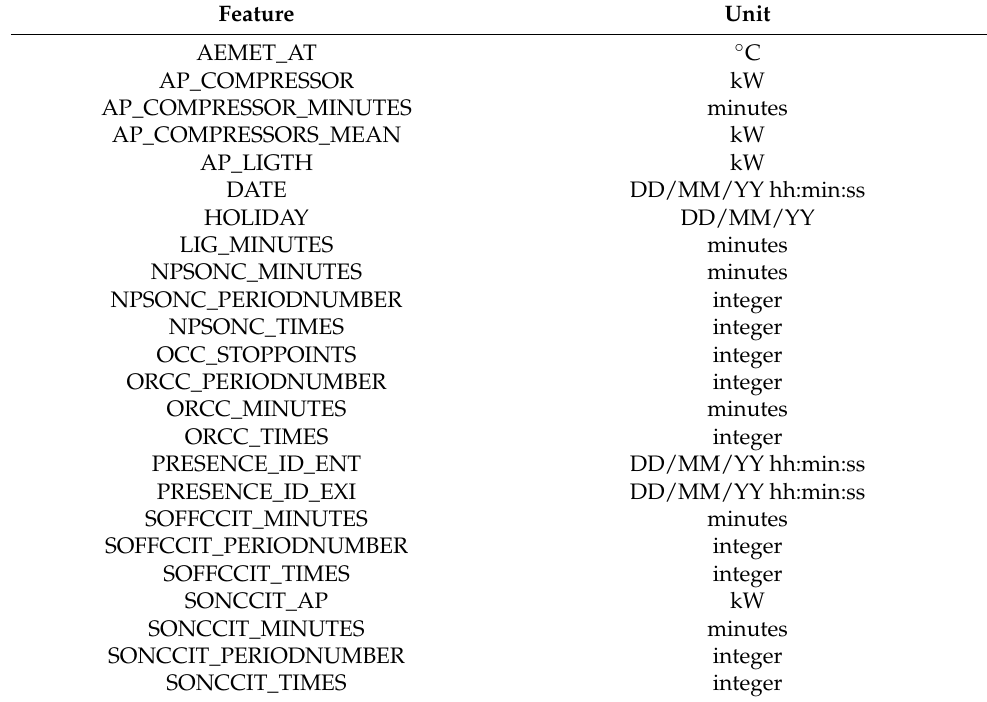
Table 1. Selected features.